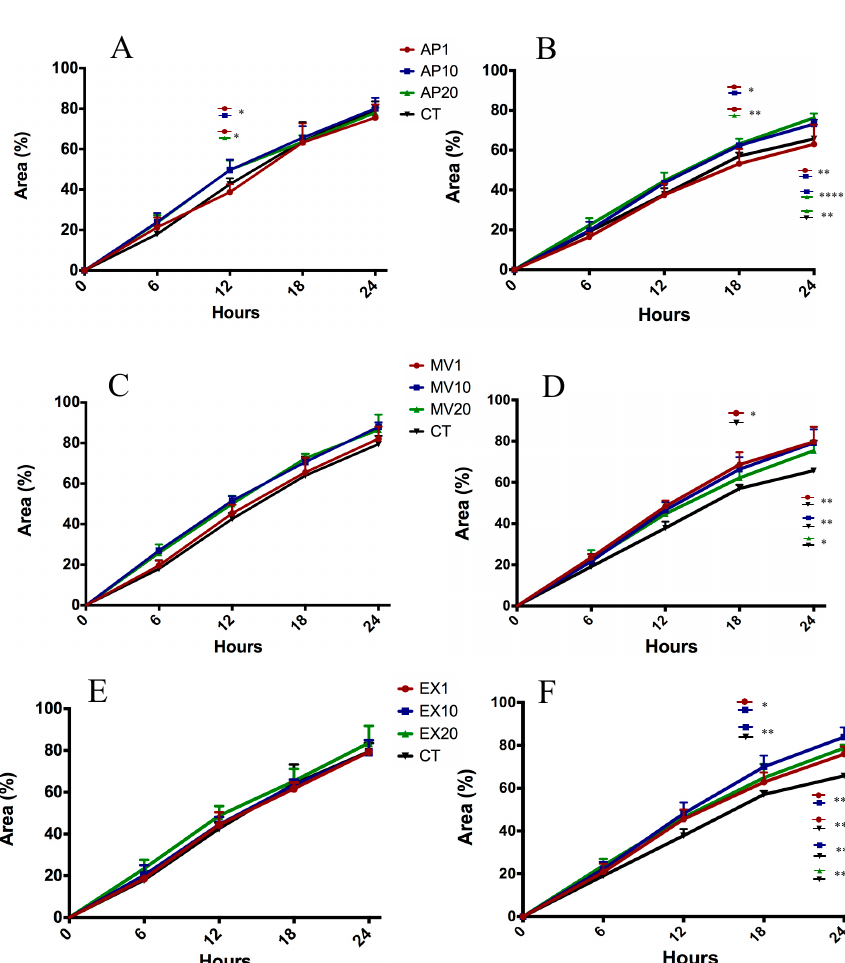
Figure 6. Primary dermal fibroblast migration is modulated by PKC-derived EVs but is not dose dependent. HaCaT- or PKC-derived ( A , B ) APs, ( C , D ) MVs or ( E , F ) EXs were added to scratch-wounded primary fibroblast cultures to a final total EV protein concentration of 1 µg, 10 µg or 20 µg/0.1 mL DM as indicated. The fibroblasts were incubated at 5% CO 2 and 37 °C and allowed to migrate for 24 h with images captured at 6 hourly intervals. Image analysis was performed using ImageJ and data are presented as the mean percent area of wound coverage in µm 2 ± SD, from at least 3 independent biological replicates. Two-way ANOVA and Tukey’s multiple comparison tests were used to evaluate statistical significance, which is denoted as * where p < 0.05; ** p < 0.01; *** p < 0.001; and **** p < 0.0001. AP: Apoptotic bodies; MV: Microvesicles; EX: Exosomes; CT: Control. Of interest, all three EV populations derived from PKCs induced significant fibroblast migration compared to the controls (Figures 6B,D,F and 7). Specifically, PKC-derived APs did not enhance fibroblast migration at doses of 1 µg/0.1 mL or 10 µg/0.1 mL, but did significantly elevate cell migration after 24 h exposure to a dose of 20 µg/0.1 mL compared to the untreated control group ( p < 0.01) (Figure 6B). The fibroblasts migrated further after 18 h when treated with 1 µg/0.1 mL of PKC- derived MVs ( p < 0.01), or after the 24 h when treated with 1 µg/0.1 mL ( p < 0.001) or 20 µg/0.1 mL ( p < 0.05) of PKC-derived MVs (Figure 6D). Enhanced cell migration was also observed in fibroblast cultures after 24 h treatment with 1 µg/0.1 mL ( p < 0.01), 10 µg/0.1 mL ( p < 0.0001) and 20 µg/0.1 mL of PKC-derived EXs ( p < 0.001) (Figure 6F, 18 h & 24 h). However, the response of human primary dermal fibroblasts to individual EV populations was not clear when a comparison of cell migration was made between APs, MVs and EXs released from the same donor cell source and at equivalent concentrations (data not shown).